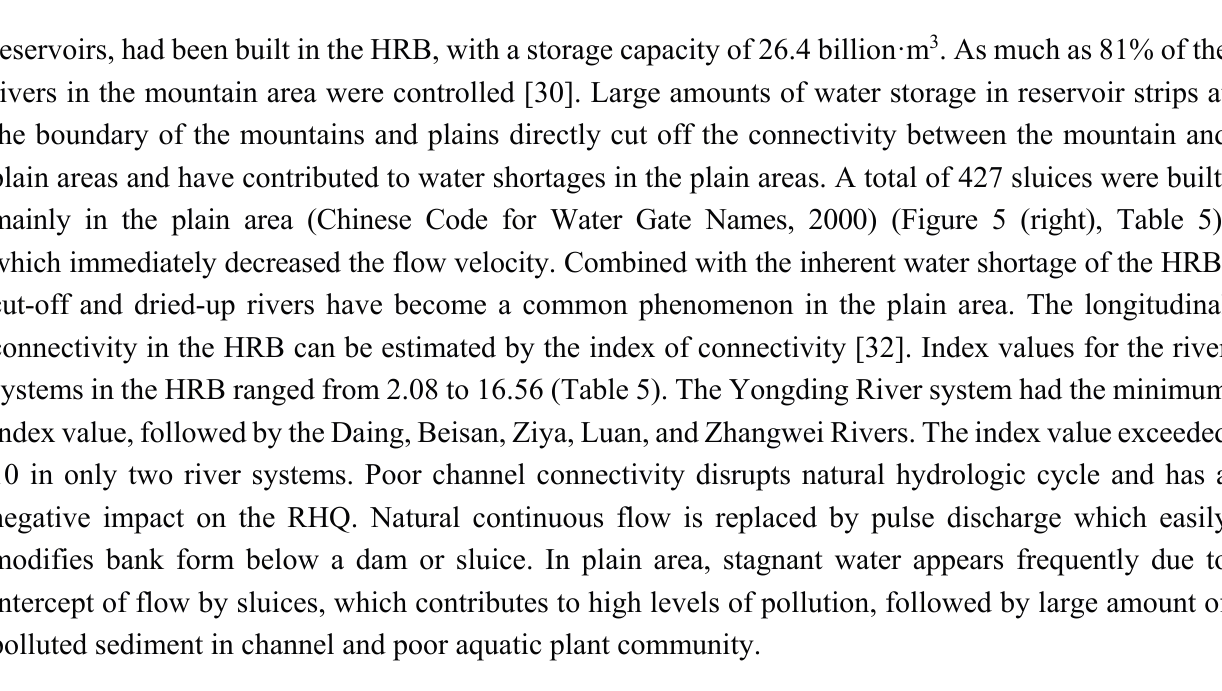
Table 5. Index of river continuity in the Hai River